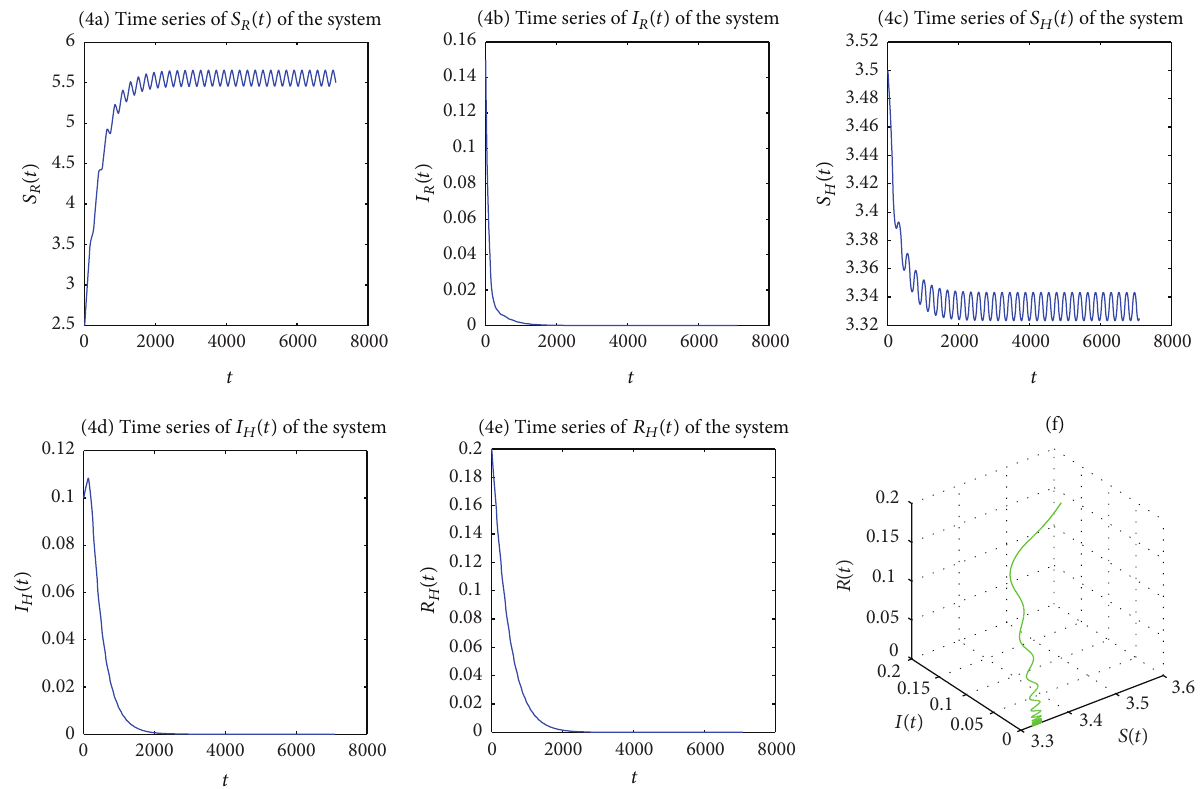
Figure 4: (a)–(e) show that the disease in system (3) with initial conditions (𝑆 𝑅 (0),𝐼 𝑅 (0), 𝑆 𝐻 (0),𝐼 𝐻 (0), 𝑅 𝐻 (0)) = (2.5, 0.15, 3.5, 0.1, 0.2) will be